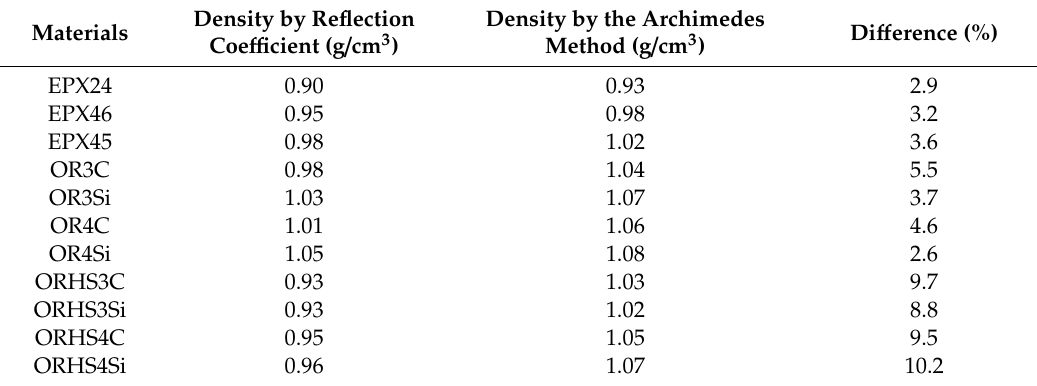
Table 1. Density calculated by reflection coe ffi cient (longitudinal wave 1 MHz). Sample materials are represented by sample name (column 1), among which EPX series belongs to the EPDM material mentioned above, OR series belongs to SBR1 material, and ORHS series belongs to SBR2